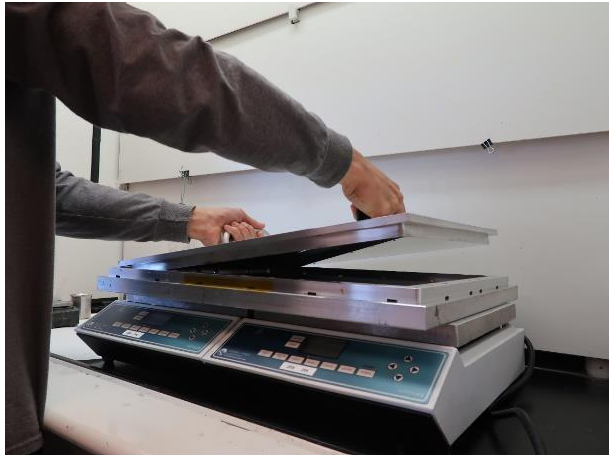
Figure 2. Mold on hotplates. Top lid being positioned in place.